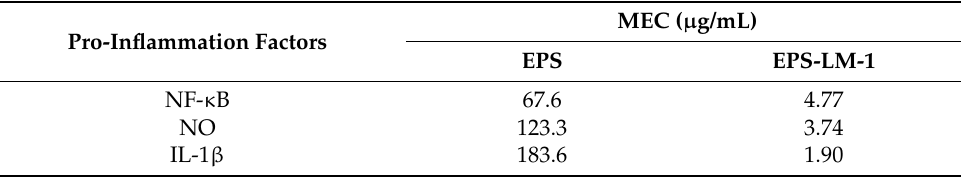
Table 3. Relative potency indexes of EPS-LM-1 compared with EPS [14] on three major inflammatory markers (MEC: minimum effective concentration for 50%